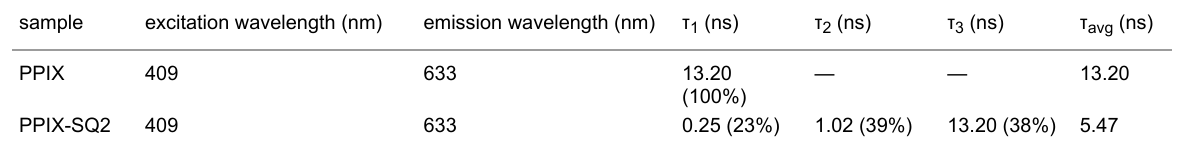
Table 1: Excited-state lifetime of the donor PPIX attached to Al 2 O 3 in presence and absence of the acceptor SQ2. sample